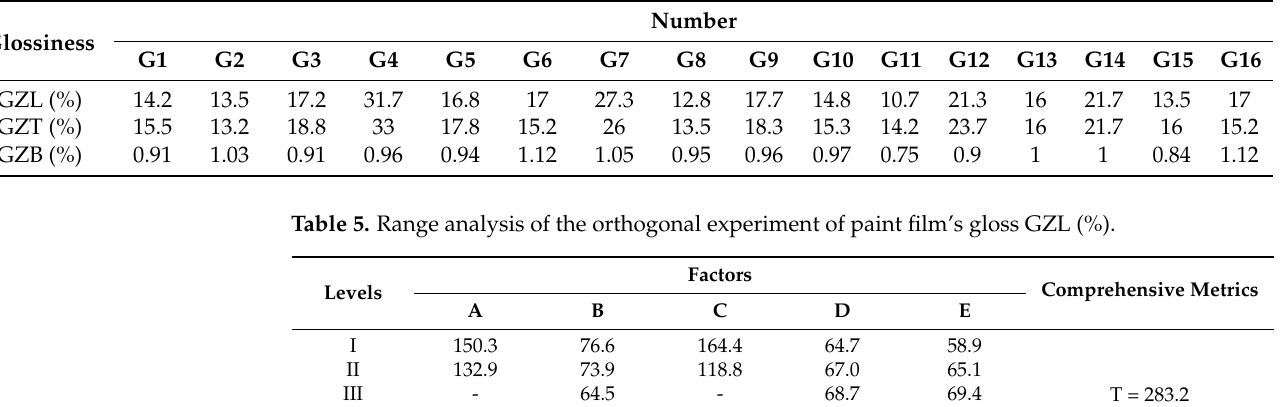
Table 4. The measured value of gloss.